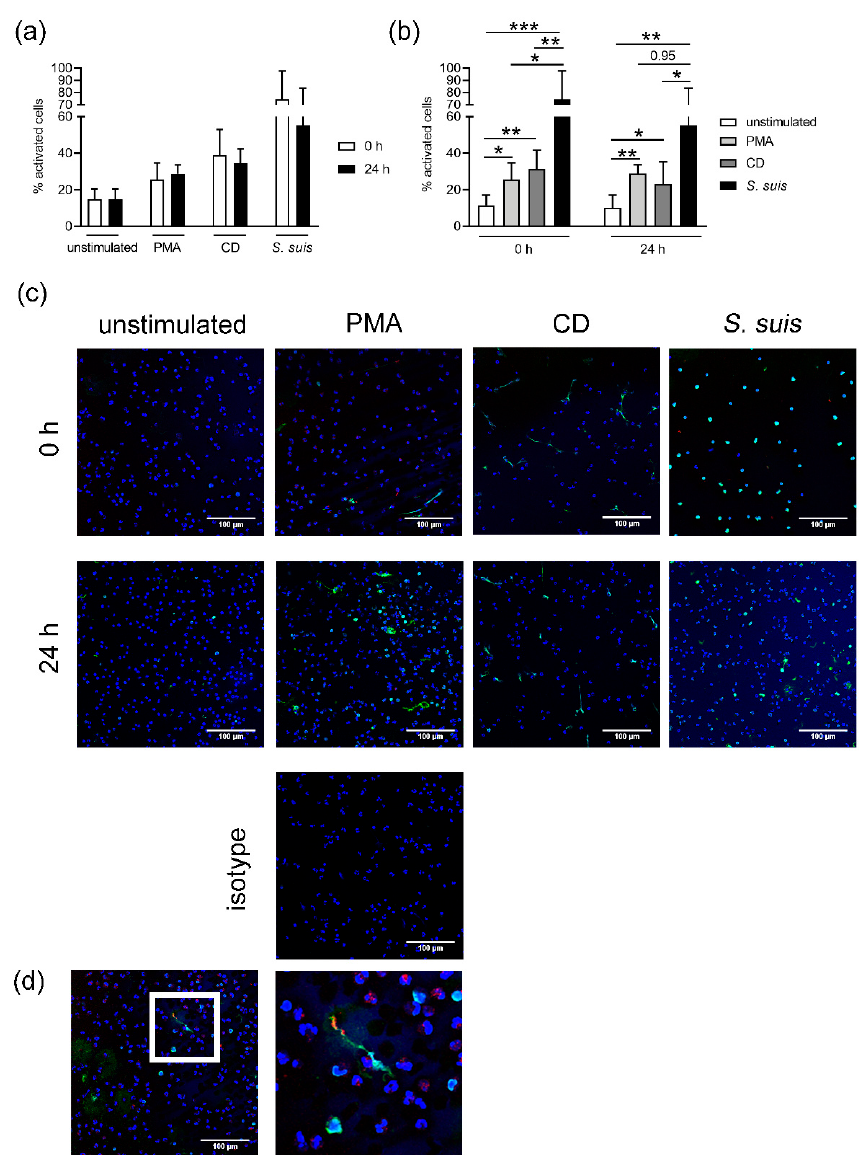
Figure 6. Neutrophil extracellular trap (NET) release was detected in neutrophils isolated from fresh and stored blood, independent of the stimulus. In each experiment and for each sample, six randomly taken pictures from two individual slides were analyzed for quantification. All cells on the six pictures were counted and the mean of activated cells per experiment was calculated and used for statistic. RPMI was used as unstimulated control. Methyl- β -cyclodextrin (CD) and phorbol 12-myristate 13-acetate (PMA) diluted in RPMI were used as positive controls. ( a ) Data are presented sorted by the stimulus. No significant di ff erence was detected when comparing the di ff erent stimulations. ( b ) Data are presented sorted by the storage and statistic was calculated inside the respective storage group. Slightly higher NET release was detected in neutrophils from fresh blood after CD or Streptococcus suis ( = S. suis cps type 2 strain 10) stimulation. Slightly higher NET release in neutrophils from stored blood was detected after PMA stimulation. Data were analyzed with one-tailed paired Student’s t -test ( n = 3 PMA, S. suis ; n = 5 CD, unstimulated) and presented with mean ± SD (* p < 0.05, ** p < 0.01, *** p < 0.001). In c and d, blue staining represents DNA (Hoechst), green marks DNA / histone-1-complexes and red denotes myeloperoxidase. ( c ) Representative images (overlay) of NET-induction assays used for quantification of activated cells are presented. The respective isotype control (PMA stimulated) used for the microscope settings is shown. ( d ) Shows a myeloperoxidase and DNA / histone-1 positive NET fiber. A triple zoom from the area marked with the white square is presented in the right